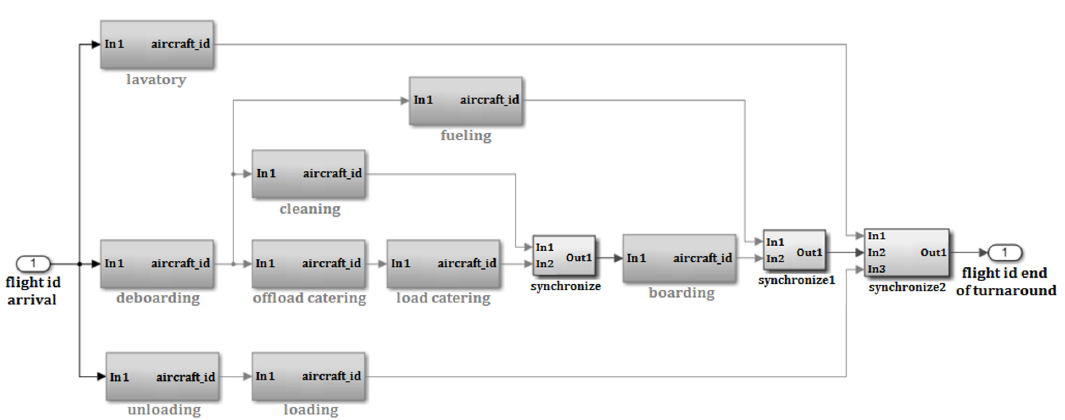
Figure 7. Simplified discrete event turnaround